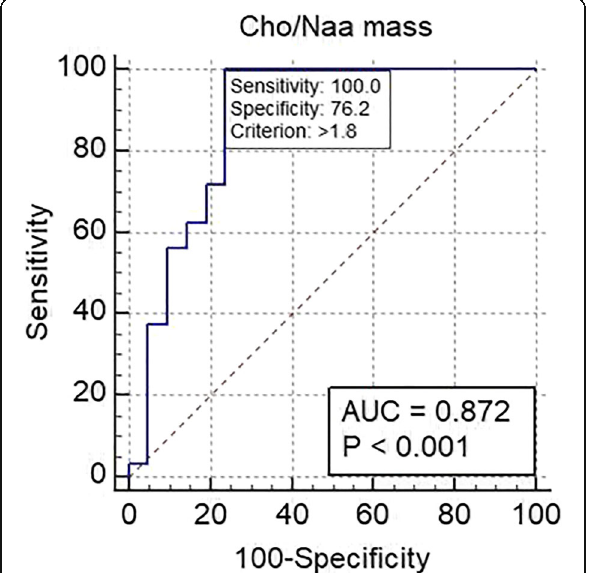
Fig. 6 ROC Curve Cho/NAA